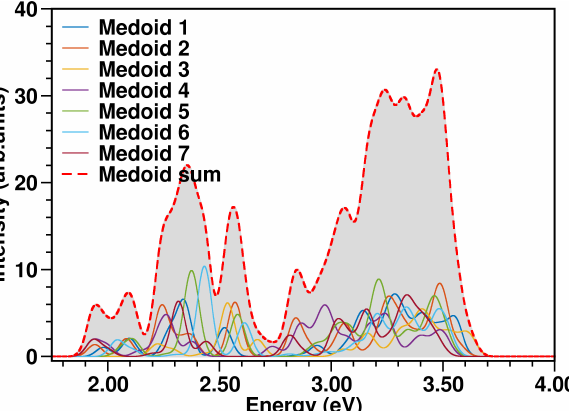
Figure 10. N3 4 − absorption spectra (in eV) calculated at TD-B3LYP/C-PCM/def2-SVP/SDD(Ru) level of theory from each medoid, weighted by the population of the corresponding cluster and the spectrum resulting from the sum over the medoids (red dashed curve). The color code is presented in the graph legend. See Equation (5) and the procedure explained in Section 3.4 for more